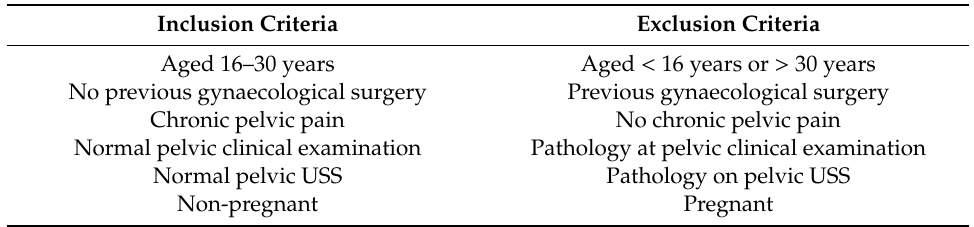
Table 1. Inclusion and exclusion criteria for a cross-sectional study of patients with chronic pelvic pain (CPP) attending the LWH.